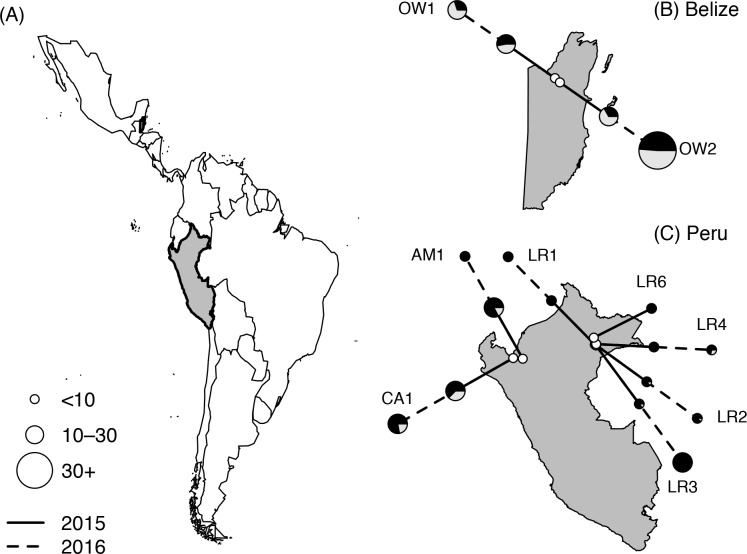
Vampire bat sampling sites in Latin America, with Belize and Peru shown in grey with black outlines (A). Insets show the location of sampling sites (white) and the prevalence of Bartonella per site (B and C) across study years (solid line = 2015, dashed line = 2016), with black denoting the proportion of infected bats. Pie graphs are scaled by sample size. Shapefiles were obtained from the maps and mapdata packages in R [86].